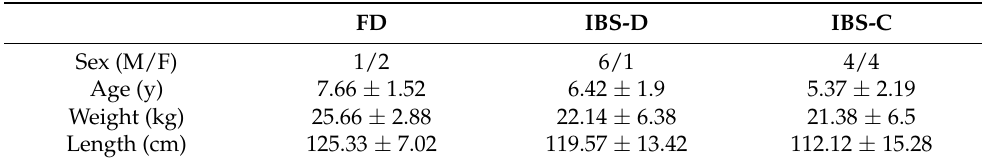
Table 1. Basic characteristics of the study